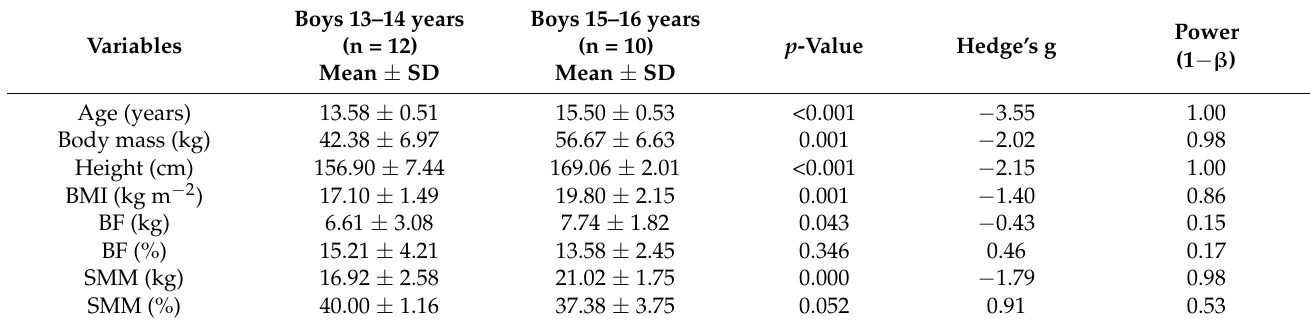
Table 2. Descriptive statistic and differences between the two group of